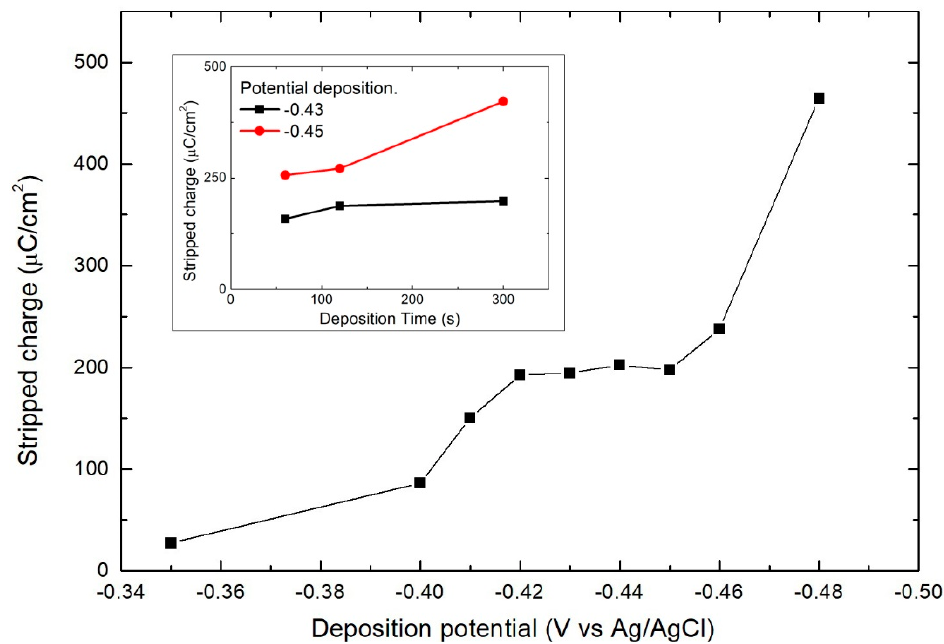
Figure 2. Growth of the amount of Bi deposited in one minute on Ag/Se ad as a function of the deposition potential. In the inset, amount of deposited Bi with the potential fixed at − 0.43 V (black) and − 0.45 V (red) as a function of the deposition time.